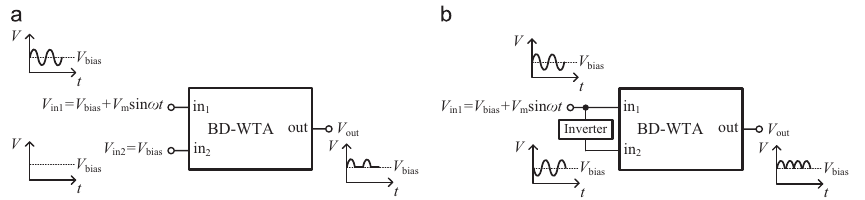
Fig. 3. BD-WTA half-wave (a) and full-wave recti fi er (b). Figure 17. BD-WTA half-wave ( a ) and full-wave rectifier ( b ) proposed in [47]. Reproduced with permission from F. Khateb, Microelectronics Journal; published by Elsevier, 2013.